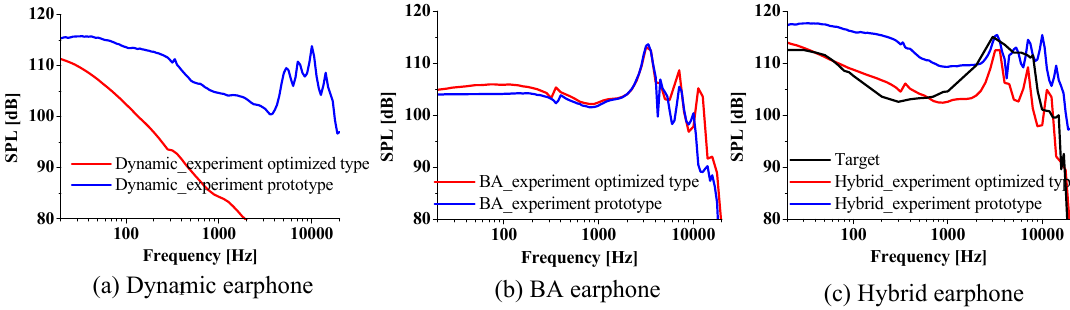
Figure 19. Acoustic tube in front chamber (prototype and optimized type).